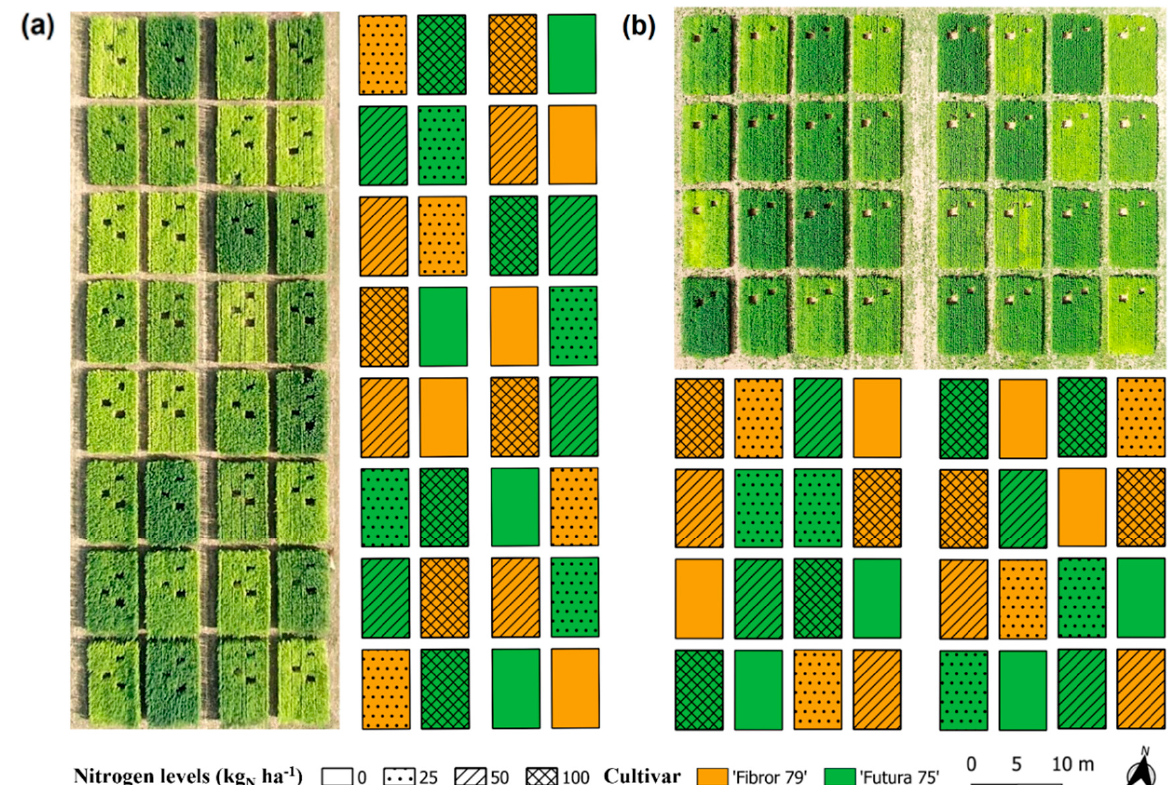
Figure 1. Experimental field design and drone picture of hemp trials in ( a ) 2020 and ( b ) 2021. Destructive samplings of 1 m 2 are observable in drone pictures.